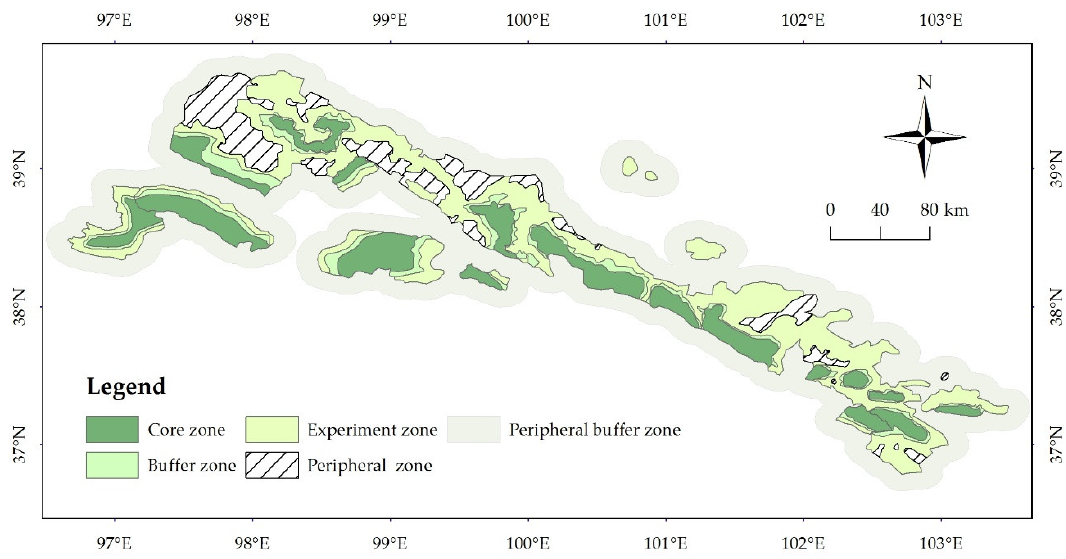
Figure 1. Location and functional zones of the Qilian Mountain Nature Reserve.